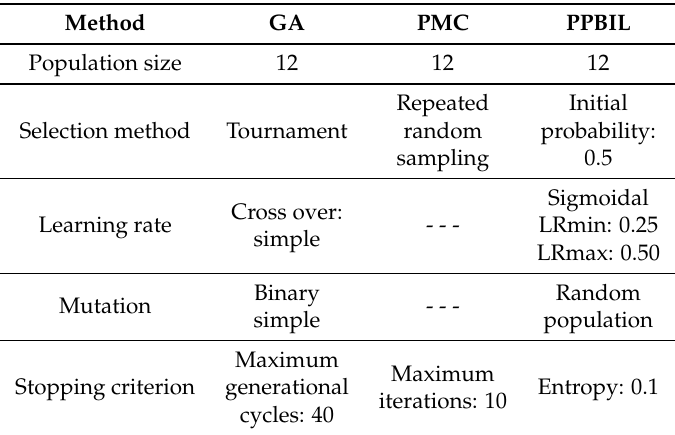
Table 3. Parameters of the location techniques